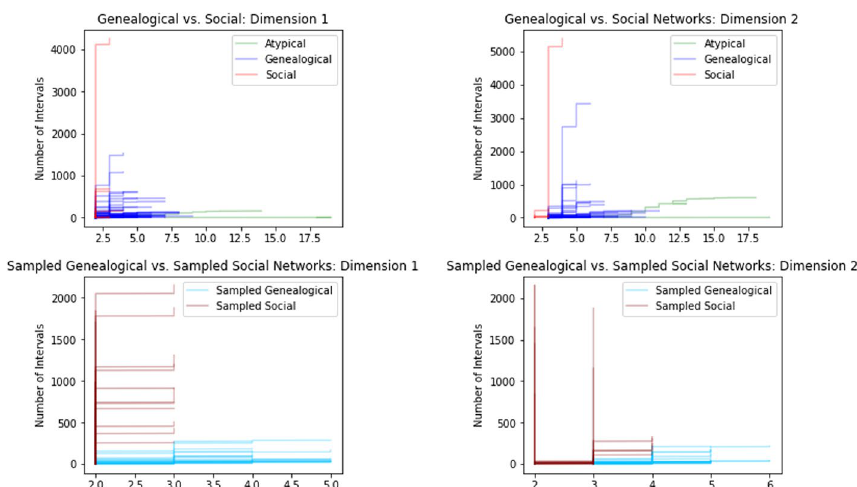
Fig. 10 Upper Row: Comparison of persistence curves for full networks by type. Lower Row: Comparison of persistence curves for sampled networks by type, excluding atypical genealogical networks. In each dimension, the average slope for genealogical networks is typically lower than the average slope for a social network. The atypical genealogical networks have the lowest average slope and much greater total length. The behavior for average slopes is more pronounced for sampled networks than for full